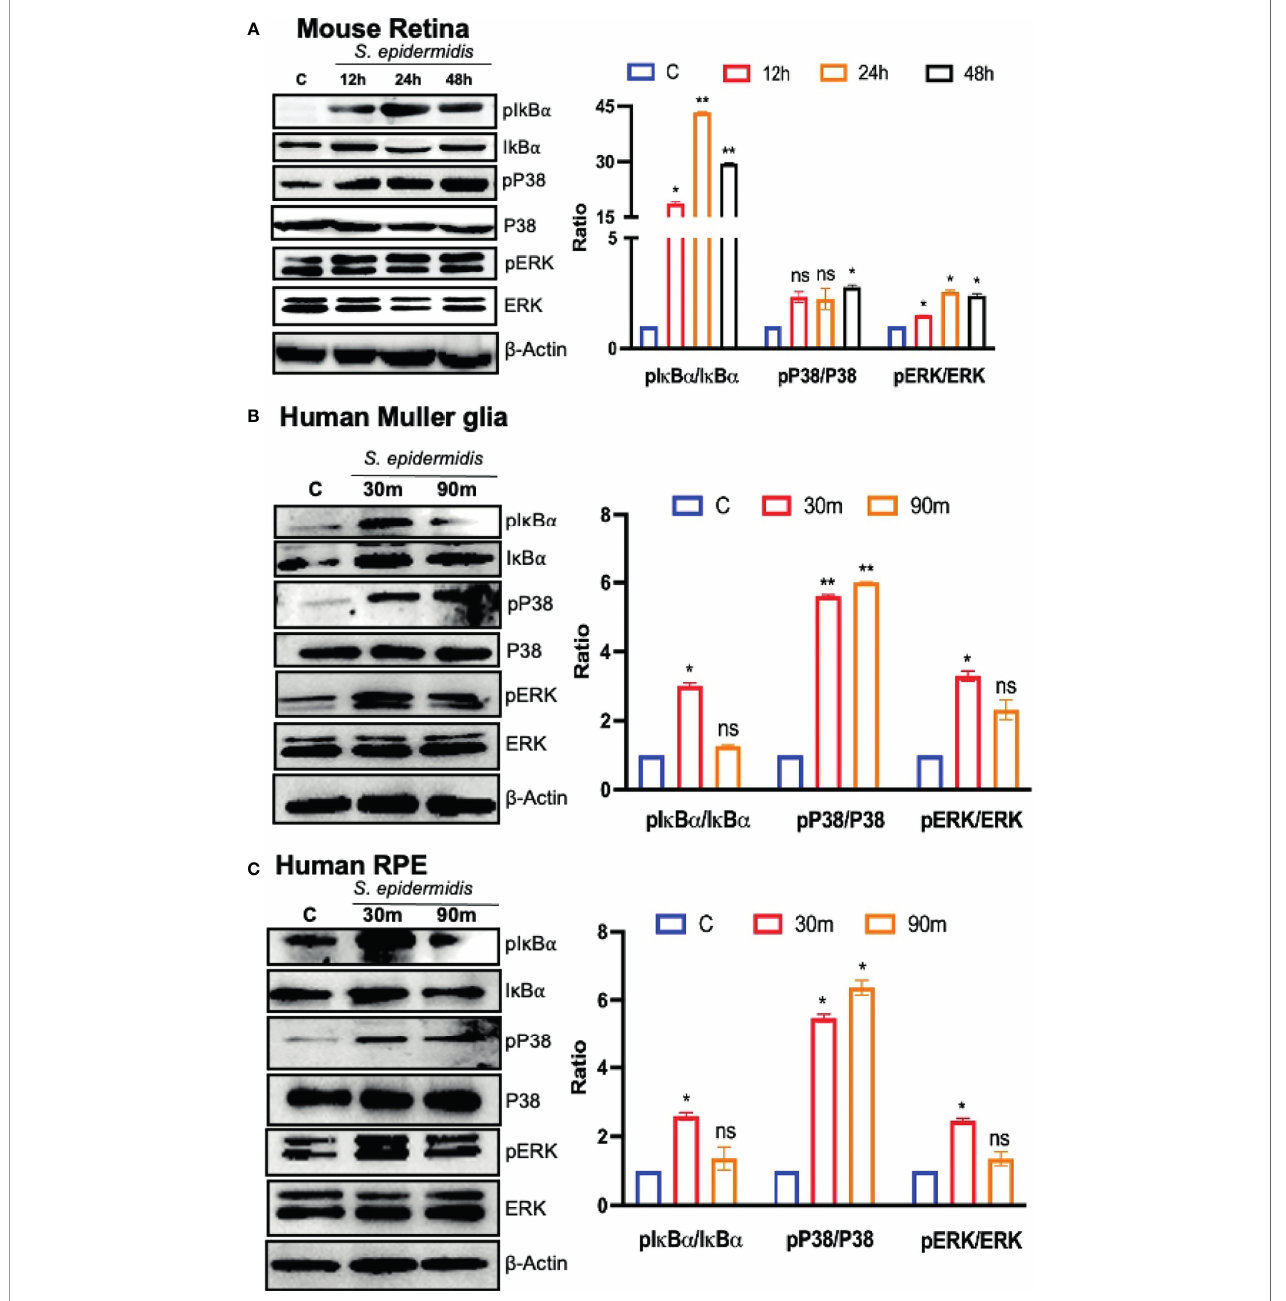
FIGURE 6 | S. epidermidis induces in fl ammatory signaling in mouse retina and cultured human retinal cells. Retinal tissues were harvested from S. epidermidis (10 7 cfu/eye) infected eyes (n = 6 eyes, 2 eyes were pooled into one sample) at the indicated time points. (A) The activations of in fl ammatory signaling proteins were assessed by western blot using speci fi c anti-I k B- a (phospho- and total), anti-ERK (phospho- and total), and anti-P38 (phospho- and total) antibodies, with b -actin as a loading control. In another experiment, cultured human retinal Muller glial cells (B) ( MIO-M1 cell line) and retinal pigment epithelial cells (C) ( ARPE-19 cell line) were infected with S. epidermidis (MOI of 10) for 30 and 90 min. Cell lysates were probed for indicated phospho- and total proteins. In all experiments, band intensities were quanti fi ed by using the Image Studio software and presented as the relative band intensity of phospho/total vs. b -actin. Statistical analysis was performed using ANOVA with Dunnett ’ s multiple comparison test (A – C) (*) p<0.05 (**) p<0.01; ns, nonsigni fi